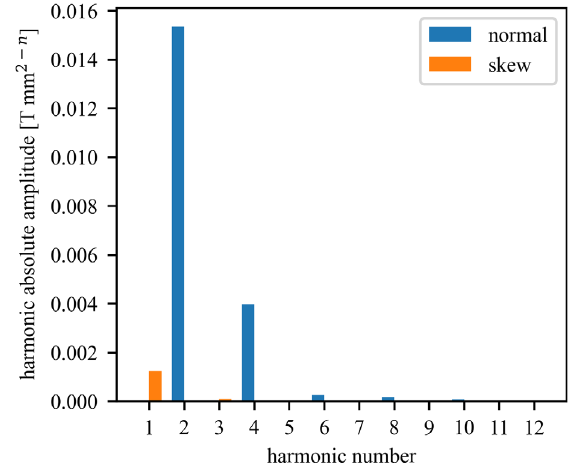
FIG. 4. 3D harmonic analysis of device and PCB together using nominal parameters and a gap of 1.5 mm.